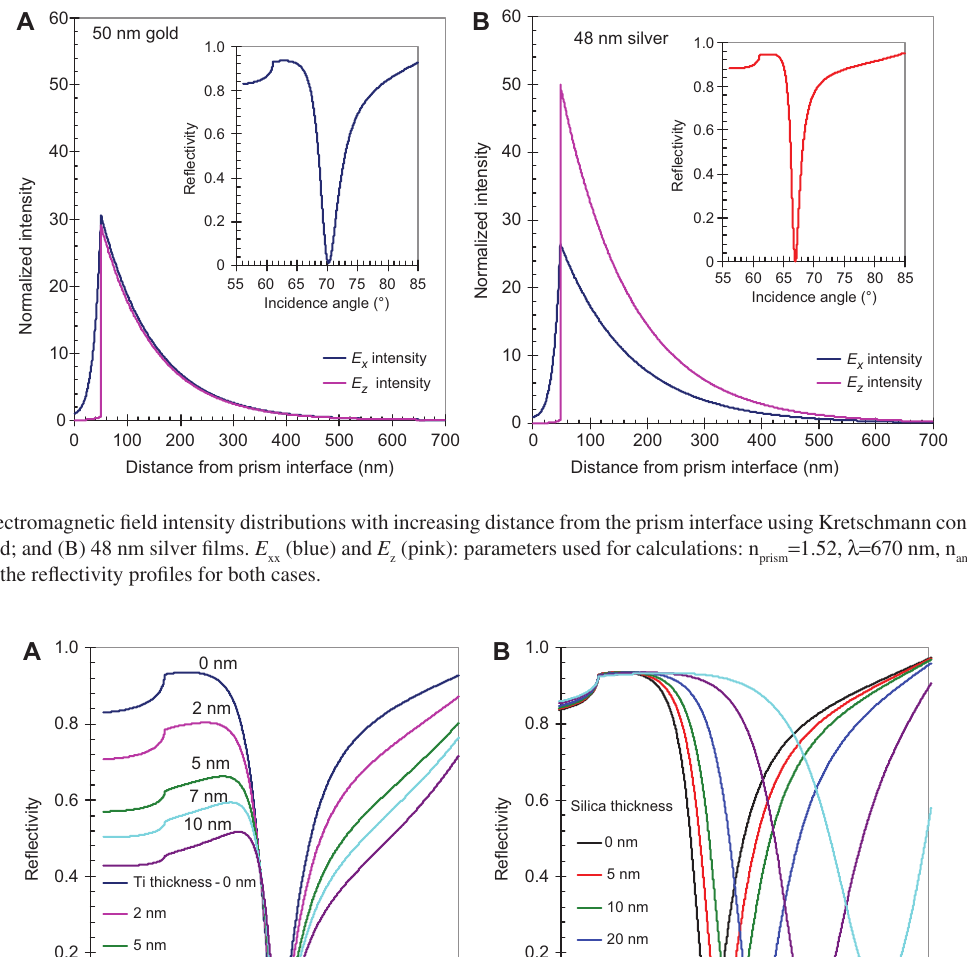
= 1.52, λ = 670 nm, n prism